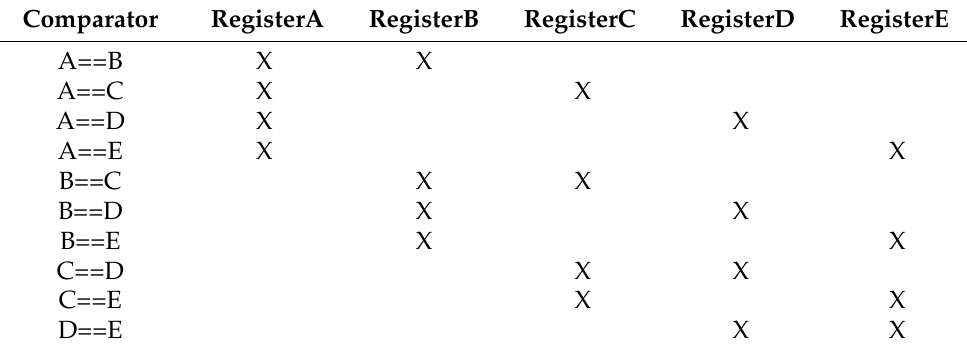
Table 1. Signals of the comparators for each pair of stored cipher data.